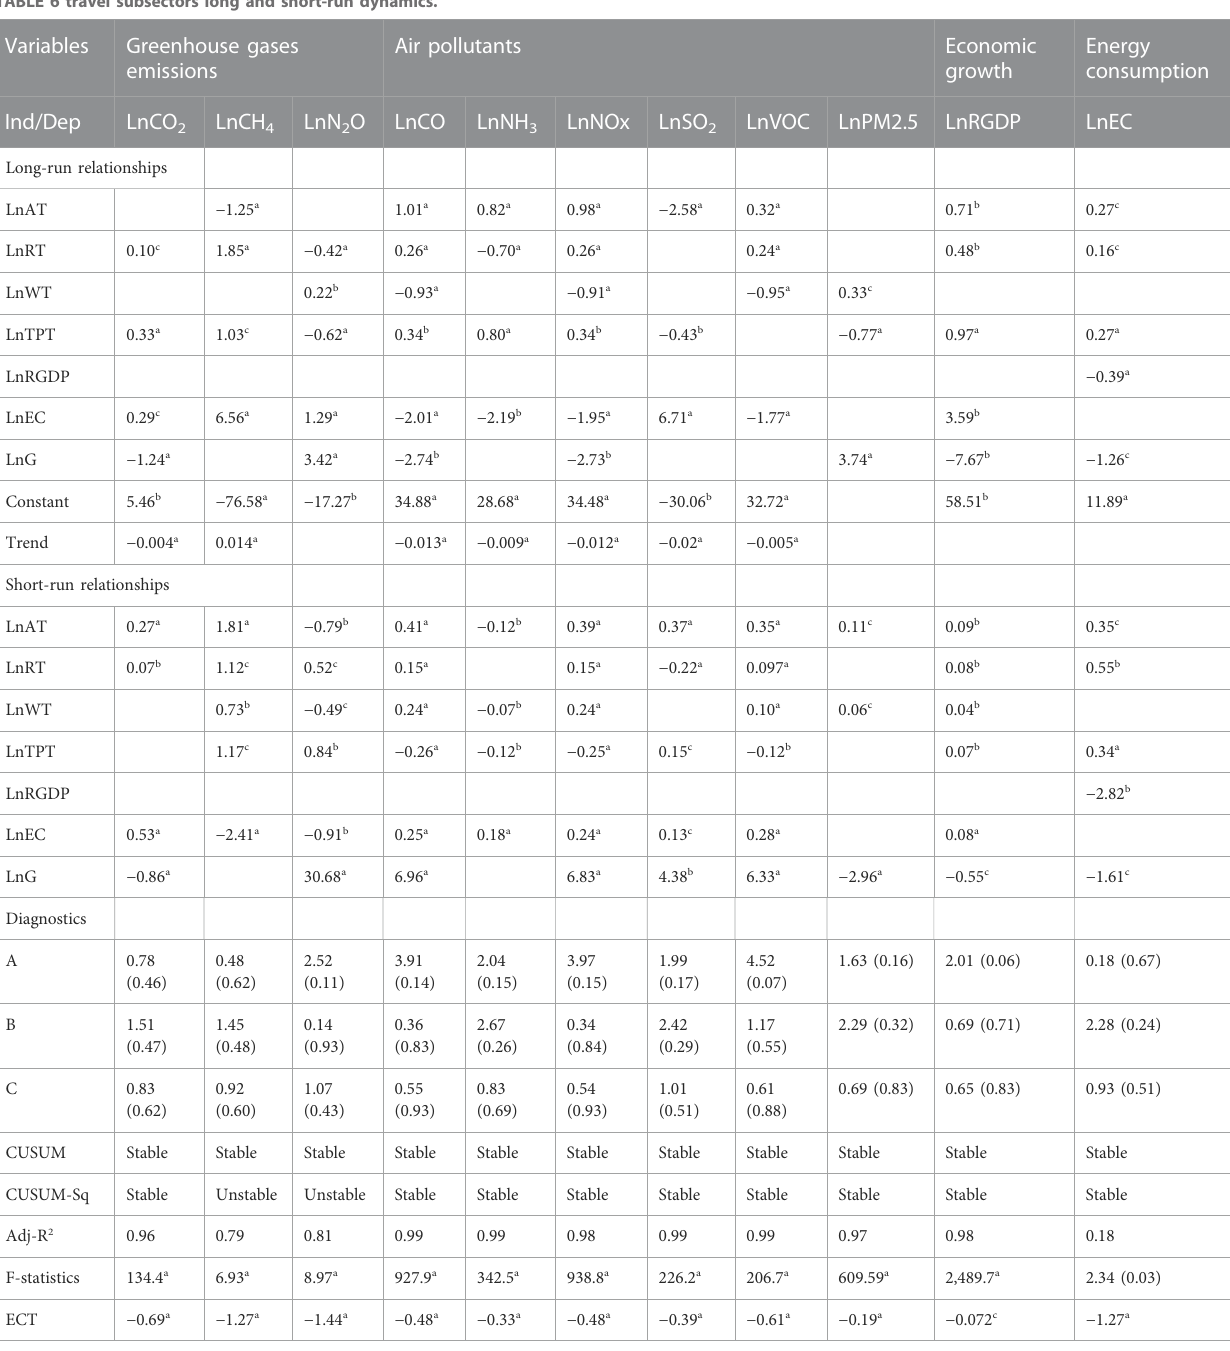
TABLE 6 travel subsectors long and short-run